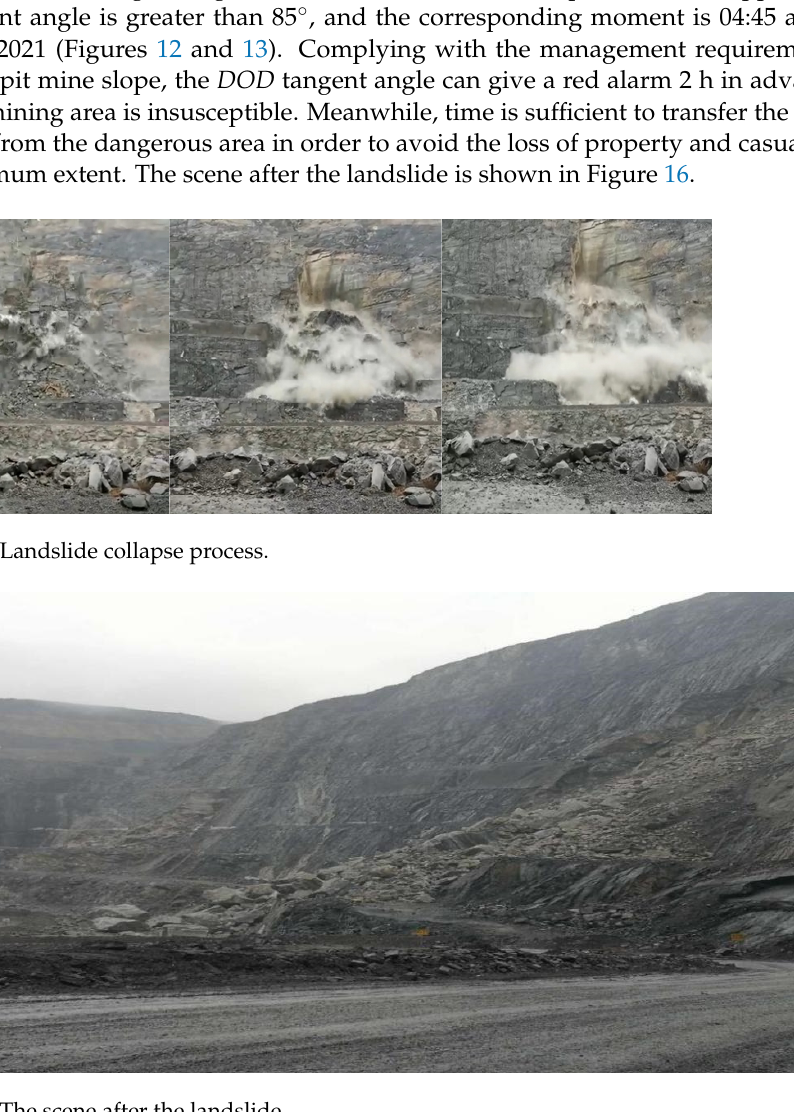
Figure 16. The scene after the landslide.